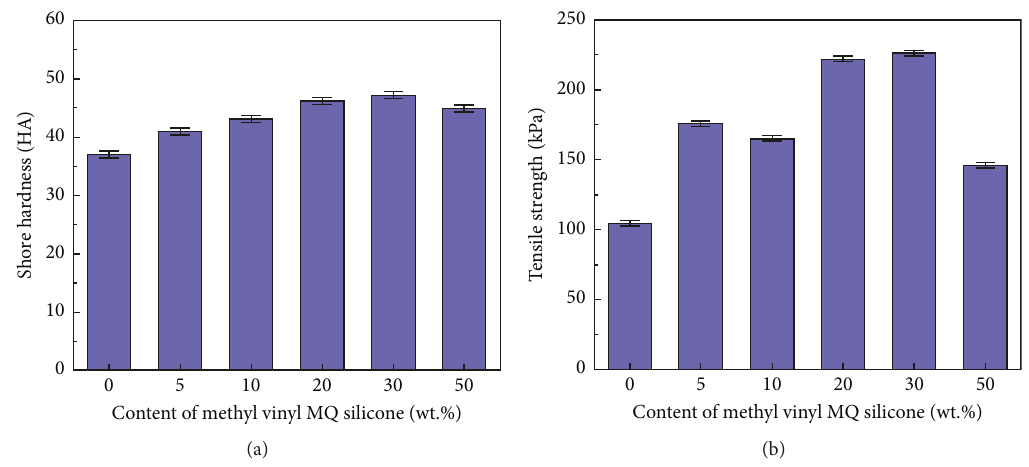
Figure 4: (a) Shore hardness and (b) tensile strength with different contents of methyl vinyl MQ